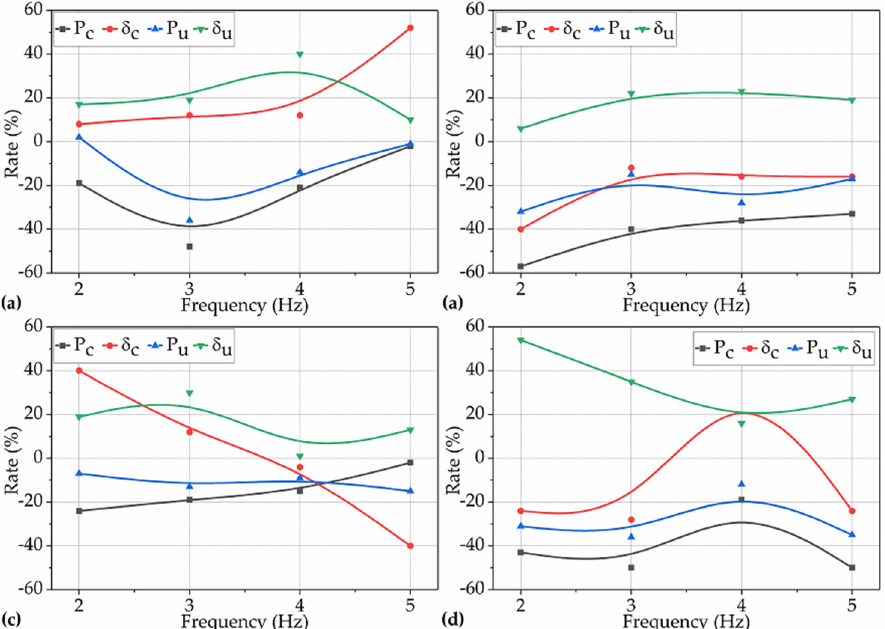
Figure 10. The effects of vibration frequency on the flexural properties of newly placed PVA-ECC bridge repairs (NP-ECC-BRs) under the operating conditions for Var. 2 with durations of ( a ) 2 h, ( b ) 5 h, ( c ) 8 h, and ( d ) 11 h.